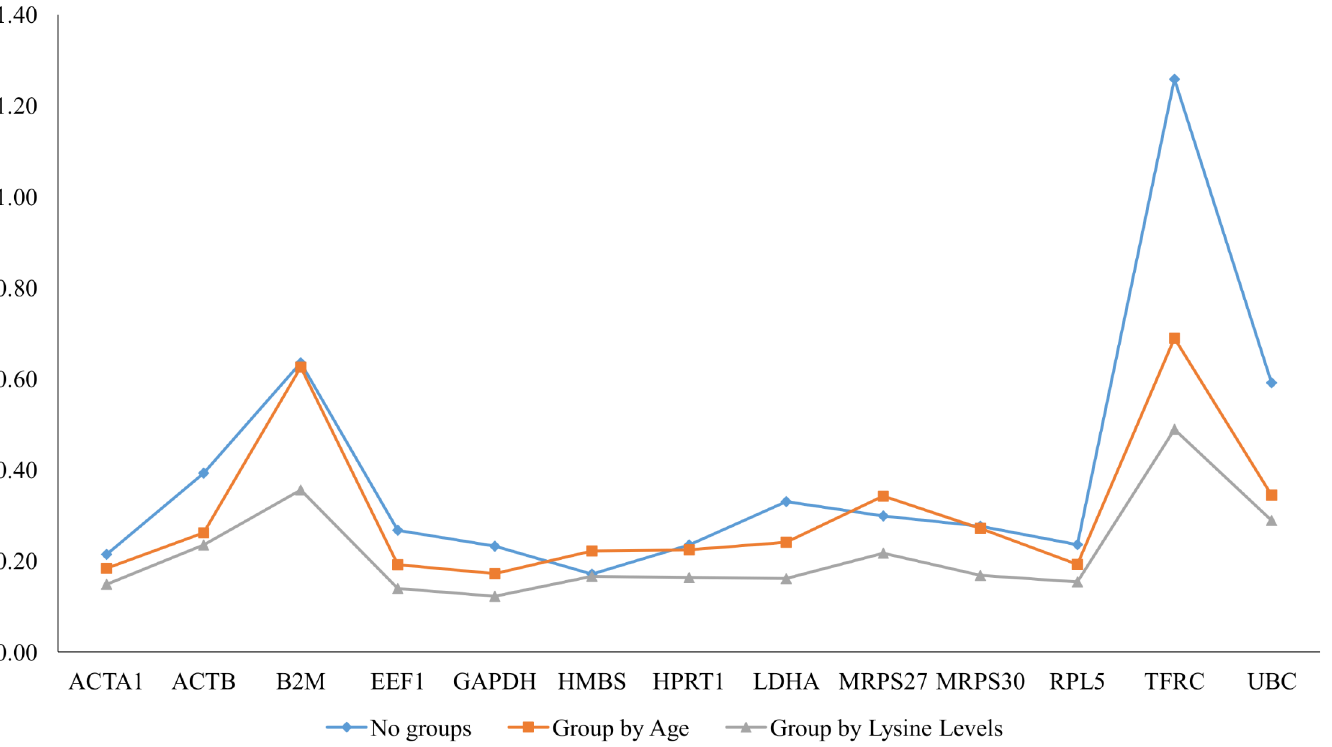
Fig 2. Reference genes stability for all treatments. NormFinder analysis of reference genes in chicken Pectoralis major muscle showing stability numbers.